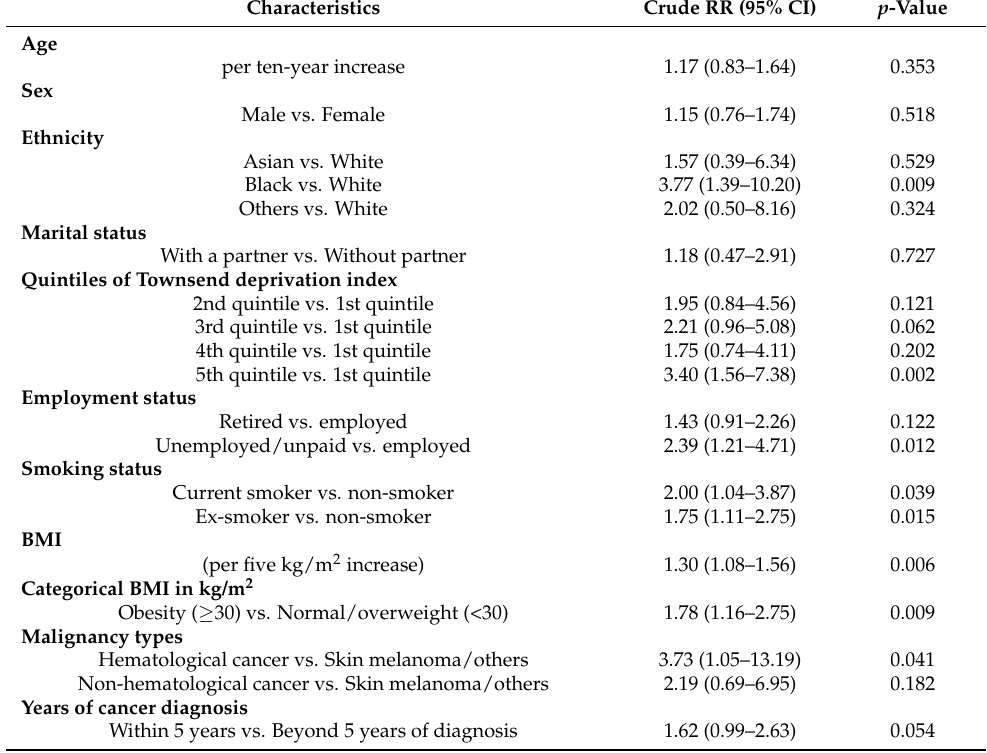
Table 2. Case-Cohort Control Study Unadjusted Risk Ratios of Testing COVID-19 Positive among UK Biobank Incident Cancer Patients by Deprivation, Age, Sex, Ethnicity, Employment Status, BMI and Cancer Types and Duration ( N = 18,917 and 89